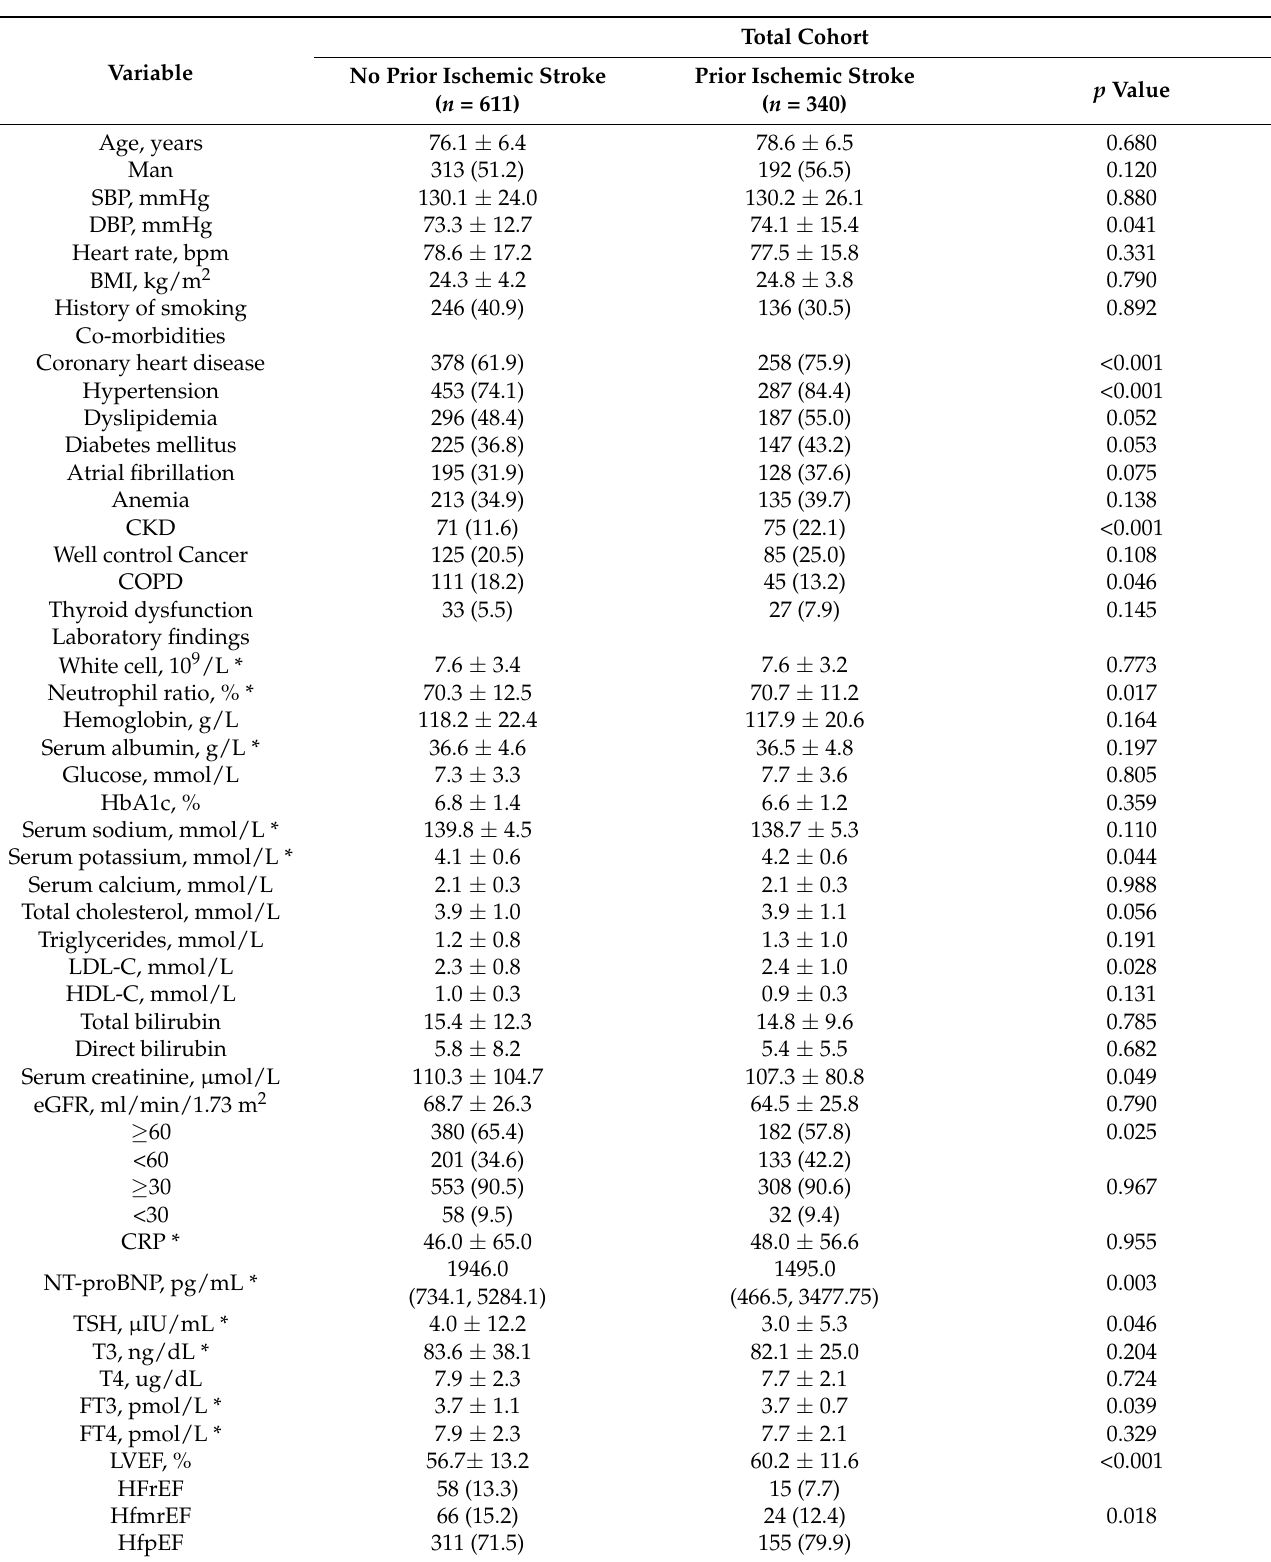
Table 1. Baseline characteristics of patients with HF by a history of ischemic